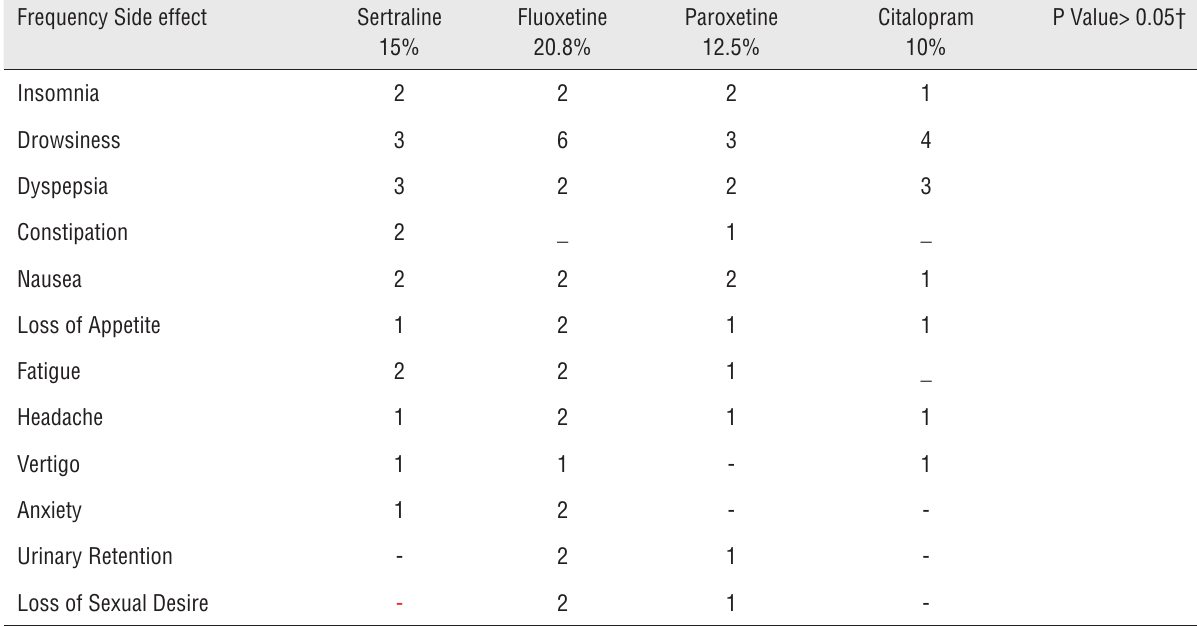
Table 3 - Side effects in four